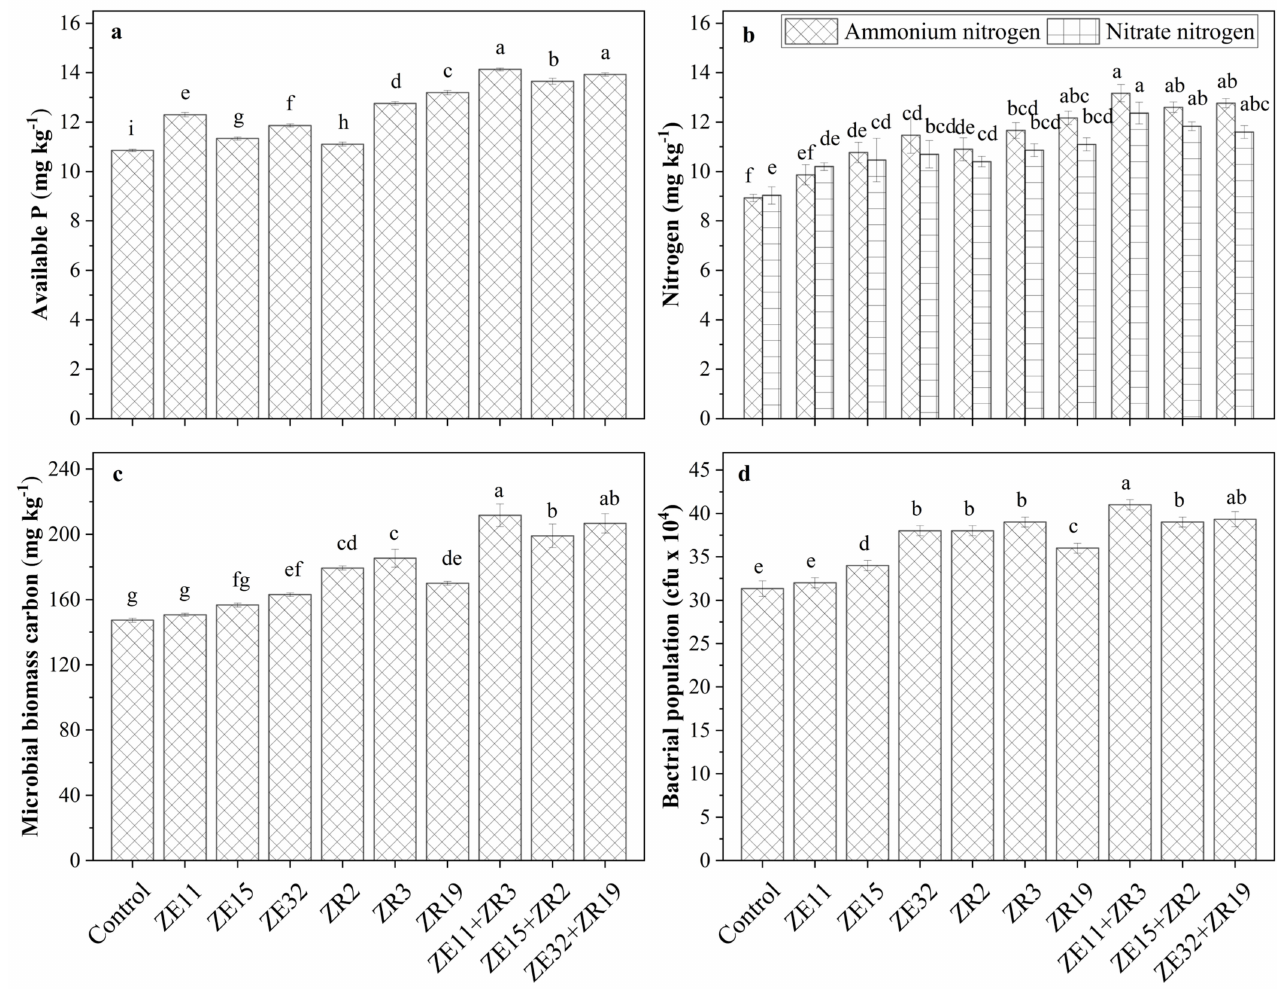
Figure 1. Effect of Bacillus and Paenibacillus species on soil biological properties. Bars followed by the same letter(s) are not significantly different according to the least significance difference (LSD) test at p ≤ 0.05. ( a ) Available phosphorous content in the soil, ( b ) ammonium and nitrate nitrogen in soil, ( c ) microbial biomass carbon, and ( d ) bacterial population per gram of